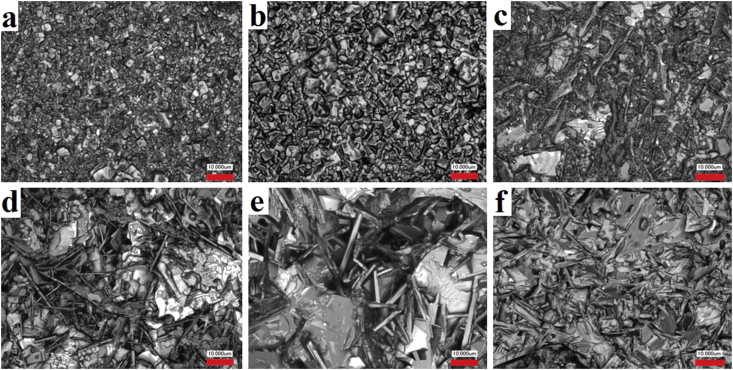
Fragments of the microstructure of the NSN solid solutions (a: x = 0.05, b: x = 0.15, c: x = 0.2, d: x = 0.25, e: x = 0.3, f: x = 1).